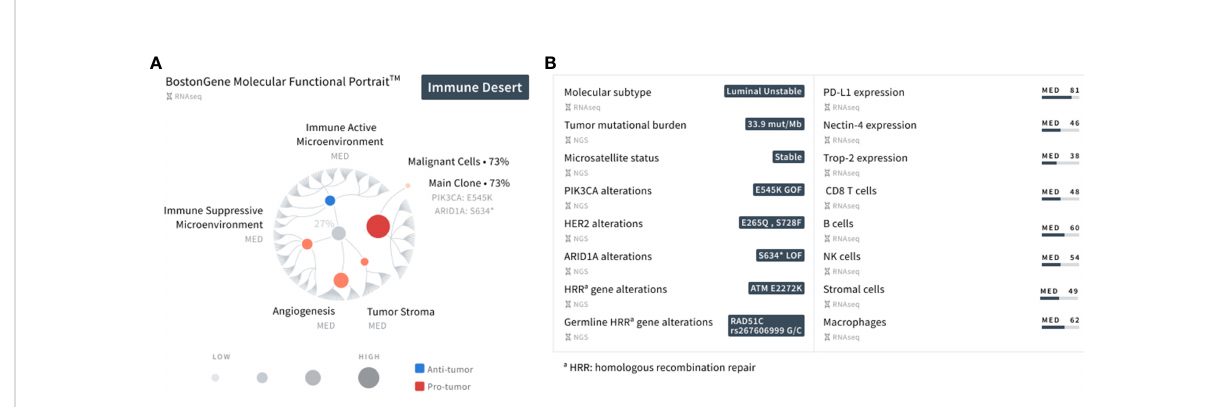
FIGURE 3 Summary of the patient ’ s major fi ndings using the MF Portrait 9 and integrative genomic and transcriptomic analysis (Data Supplement). (A) A planetary schematic representation of the molecular and functional characteristics of the patient ’ s tumor. Blue represents anti-tumor activity (immune active microenvironment) and red represents pro-tumor activity (immune suppressive microenvironment, angiogenesis, tumor stroma). The size of the dot corresponds to the strength of the presented gene signatures. (B) List of key fi ndings using WES and RNA-seq analysis represented as NGS and RNA-seq,